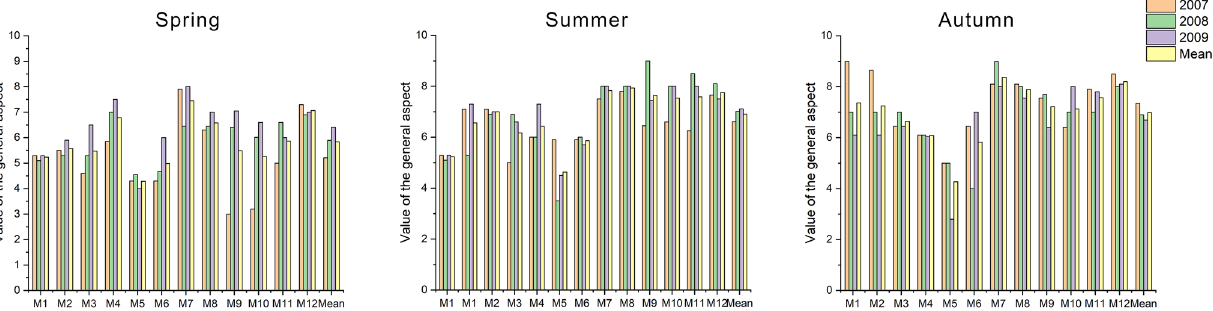
Figure 1. Ratings of pitch overall aspect across grass mixtures and research